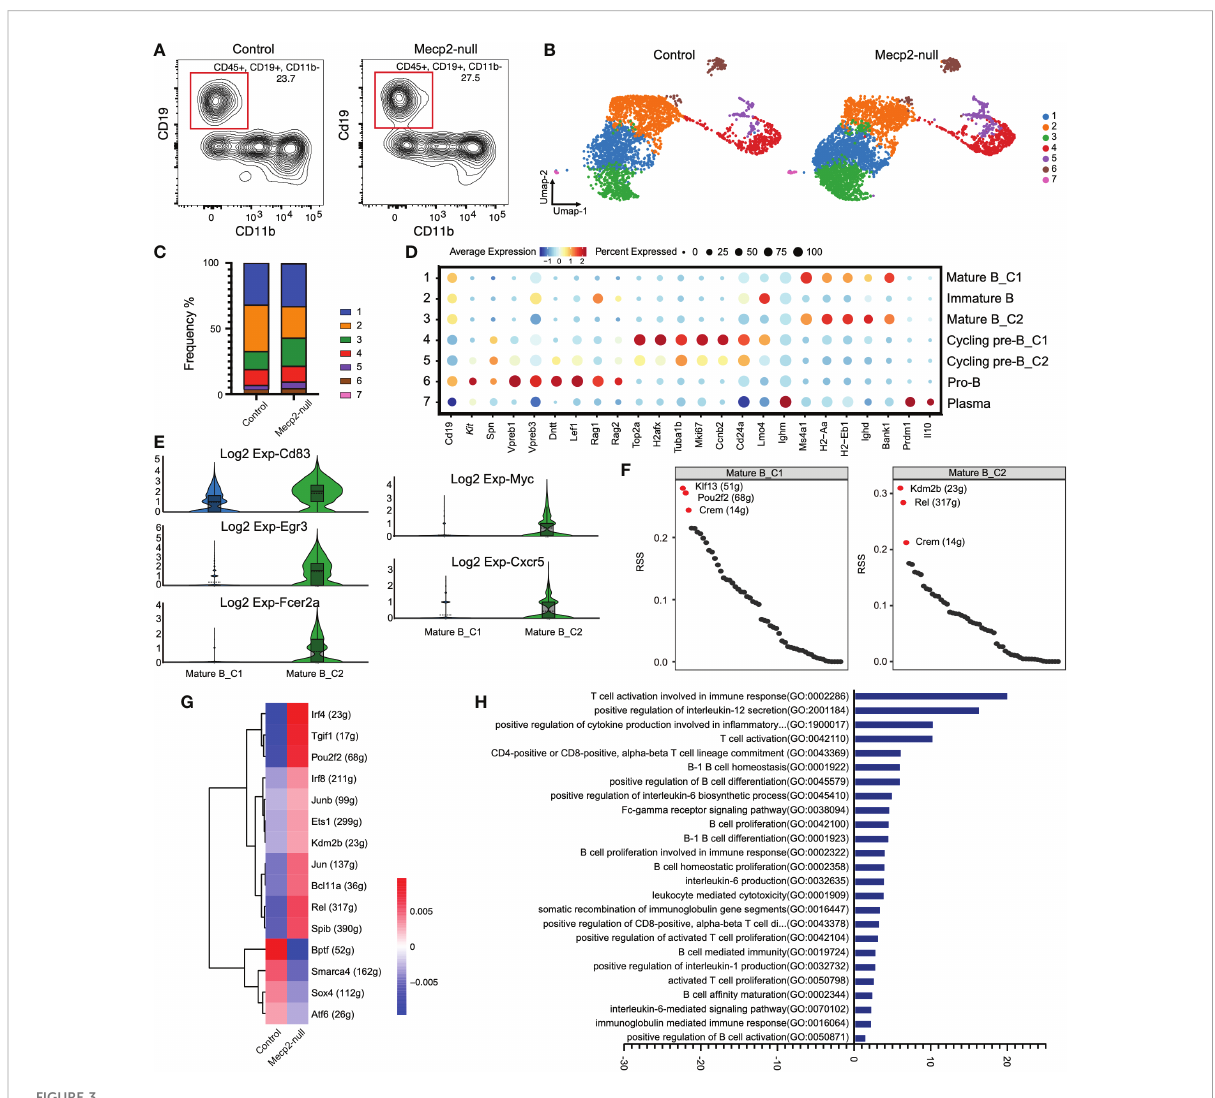
FIGURE 3 Gene expression and characterization of B cells compared to control and Mecp2 -null mice. (A) Representative fl ow cytometry contour plot showing the proportion of B cells within the CD45 + population in the dura of control and Mecp2 -null mice. B cells were gated as CD45 + CD19 + and CD11b - . n=3 for each group. (B) Distribution of seven B cell clusters on the Umap plot for two groups. Clusters are rank-ordered by size. (C) Bar plots showing cell cluster distribution within different groups. (D) Dot plots displaying the relative expression of selected B cell marker genes (columns) across clusters (rows) in (B) . Dot size indicates the fraction of cells in the clusters that express a gene. Color indicates the Z-score of mean gene expression in the cluster (Z-score of average log2). (E) Violin plots of Cd83, Egr3, Fcer2a, Myc , and Cxcr5 expression in control and Mecp2 -null mice. (F) Rank for regulons in cluster1 and cluster2 of mature B cells (Mature B_C1 and Mature B_C2) based on regulon speci fi city score (RSS). (G) Heatmap of regulon activity score (RAS) in two groups. Rows represent different regulons and columns represent mouse groups. (H) Bar plot showing different enriched pathways comparing in Mecp2 -null and control mice determined using GSVA. T -values > 0 represent up-regulated